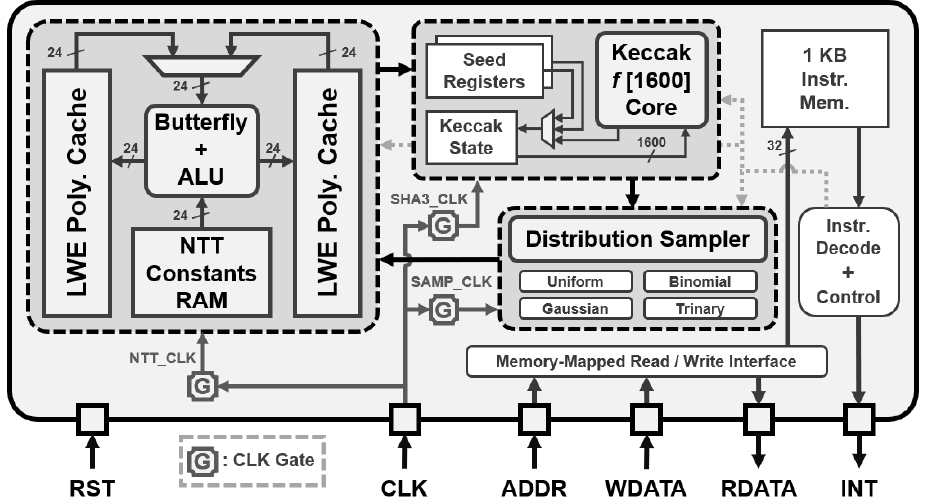
Figure 10: Sapphire lattice crypto-processor top-level